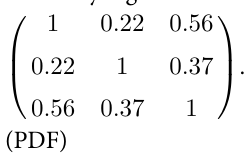
S7 Fig. Resulting species compositions from 10,000 simulations over different times (see Fig 1C). The total time of simulations in Panels A , B , C , and D are 100, 200, 400, and 800, respectively. The step size is fixed as 0.01. The simulations are conducted by the Runge-Kutta method. The black lines correspond to the borders of the analytical feasibility regions in Fig 1B. As time increases, the points on the sphere tend to cluster in the corresponding analytical feasibility regions. As a reference, the interaction matrix of the 3-species system is